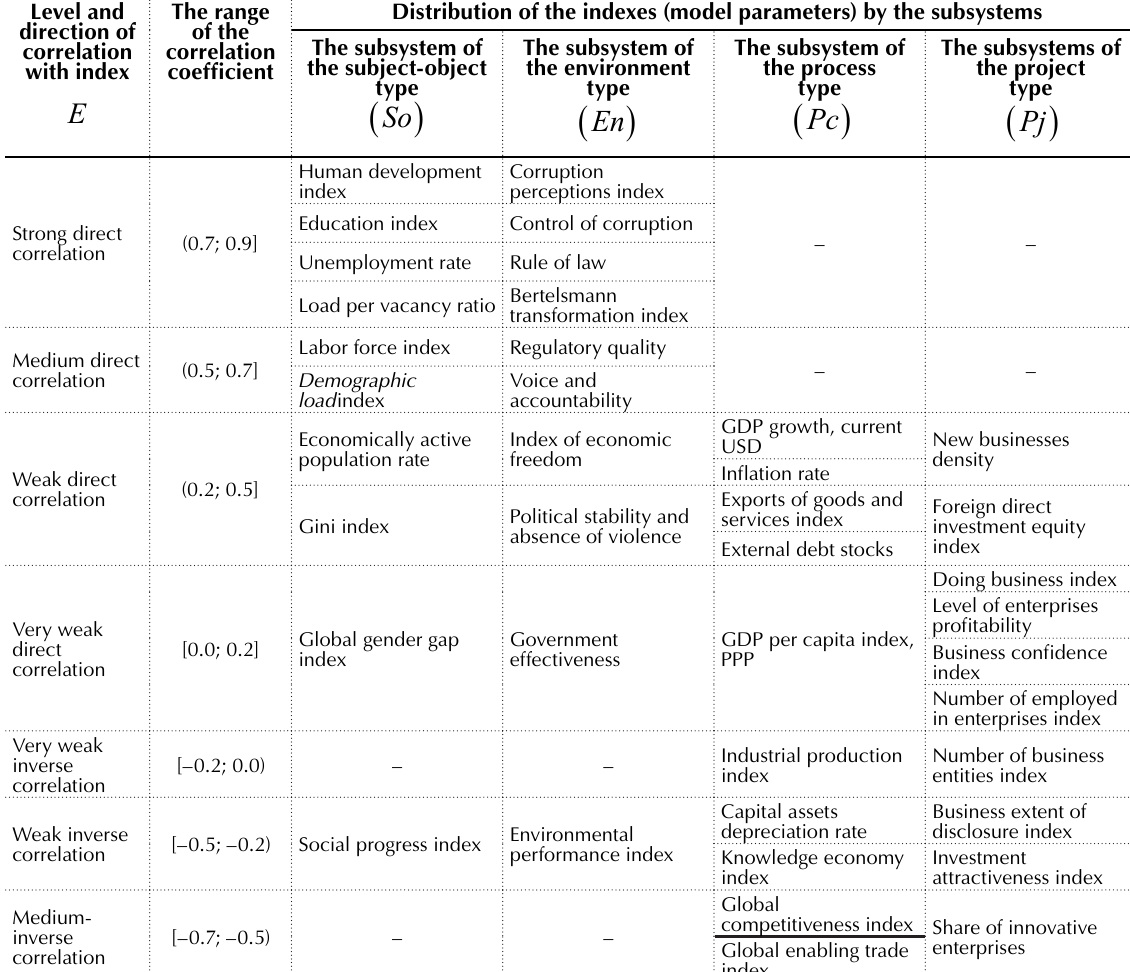
Table 3. Distribution of the model parameters by their correlation degree with the index of economic sustainability of Ukrainian socio-economic system Level and The range Distribution of the indexes (model parameters) by the subsystems direction of of the The subsystem of The subsystem of The subsystem of The subsystems of correlation correlation the subject-object the environment the process the project with index coefficient type type type type ( ) So E ( ) Pc ( ) En ( ) Pj